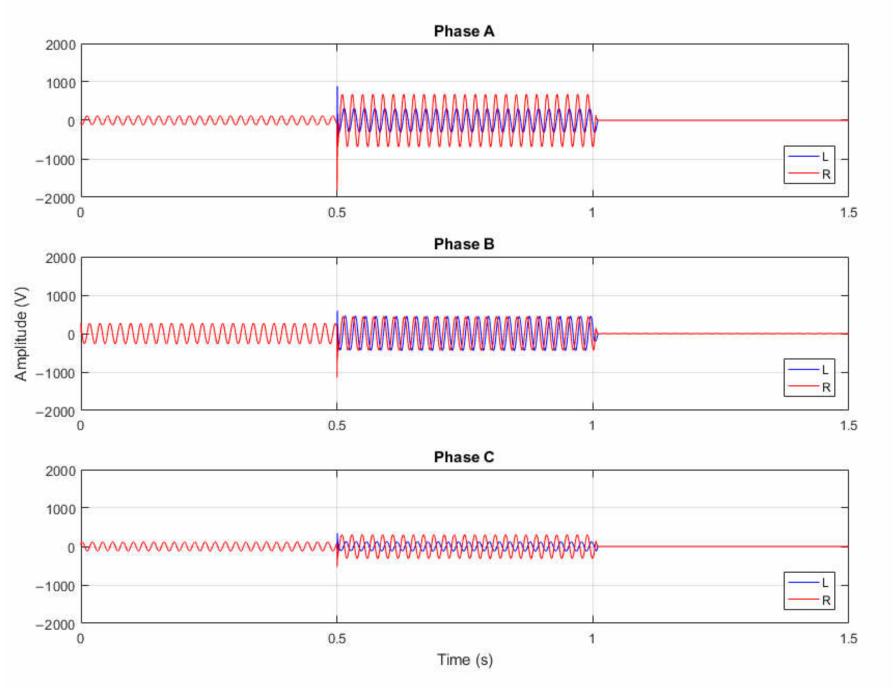
Figure 5. Voltage waveforms in three-phase cable line screens in Terminal J for neutral points grounded by the inductor and